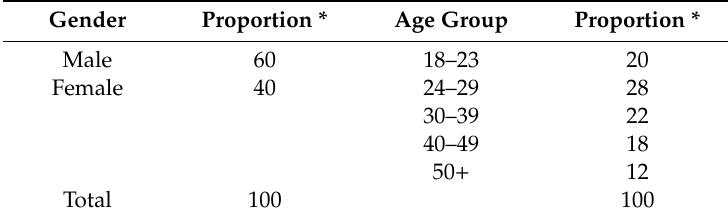
Table 2. Demographic variation of the sample population according to gender and age group.